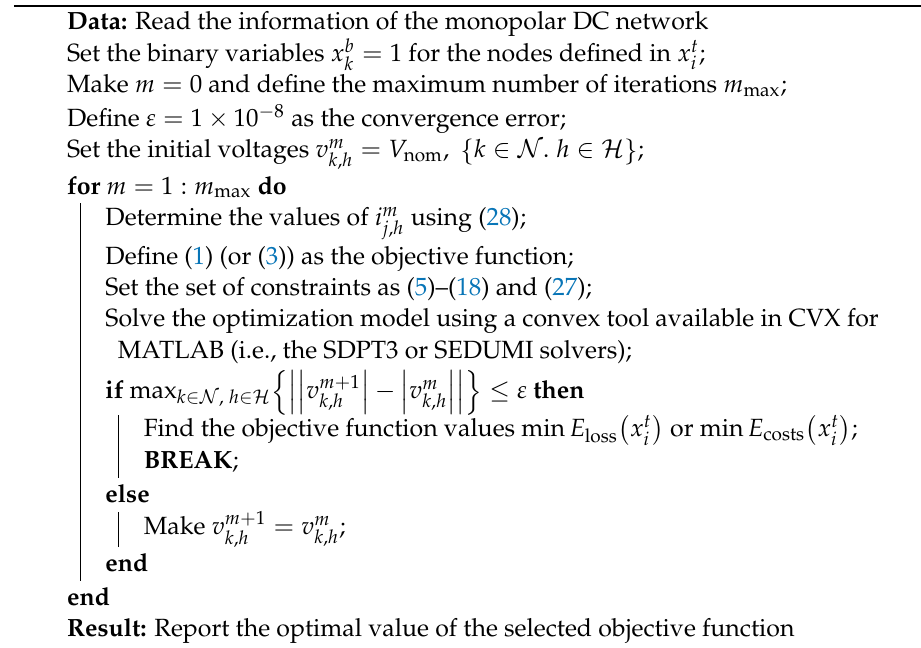
Algorithm 2: General implementation of the recursive convex solution for the optimal operation of BESS in monopolar DC grids